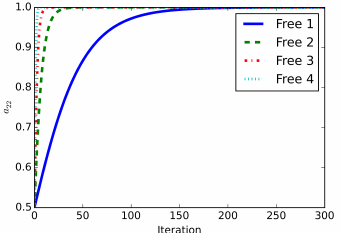
Figure 17. Optimisation process of a 22 (free to